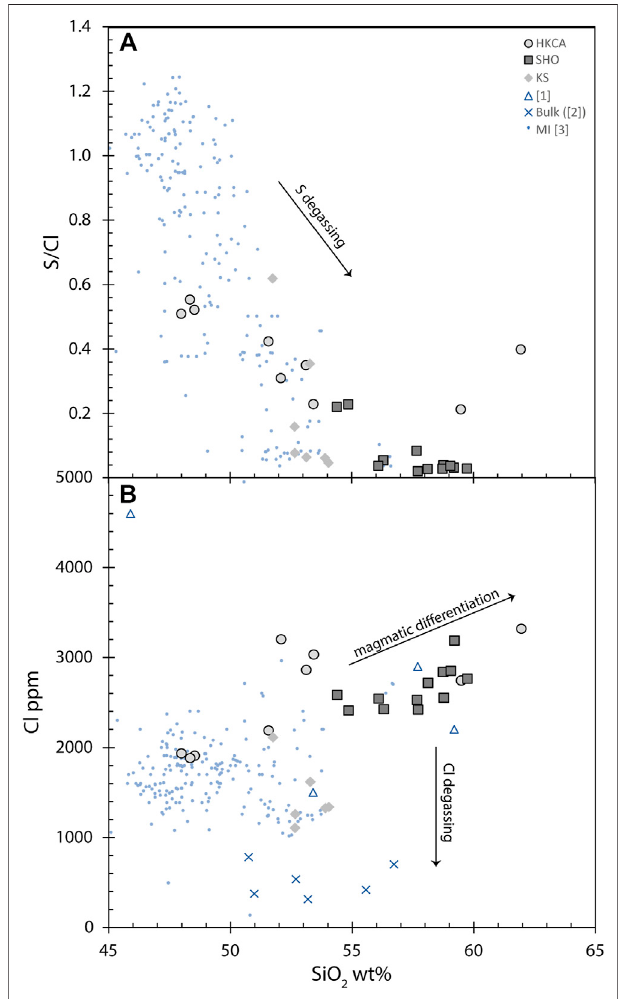
FIGURE 8 | Silica content of melt inclusions plotted against (A) S/Cl and (B) Cl content. Melt inclusions record S degassing, as re fl ected by the decreaseinS/ClwithincreasingSiO 2 ,whileClincreasesslightly.Potassicmelt inclusionshavethelowestClcontent,butallmeltinclusionsareenriched in Cl compared to Stromboli bulk